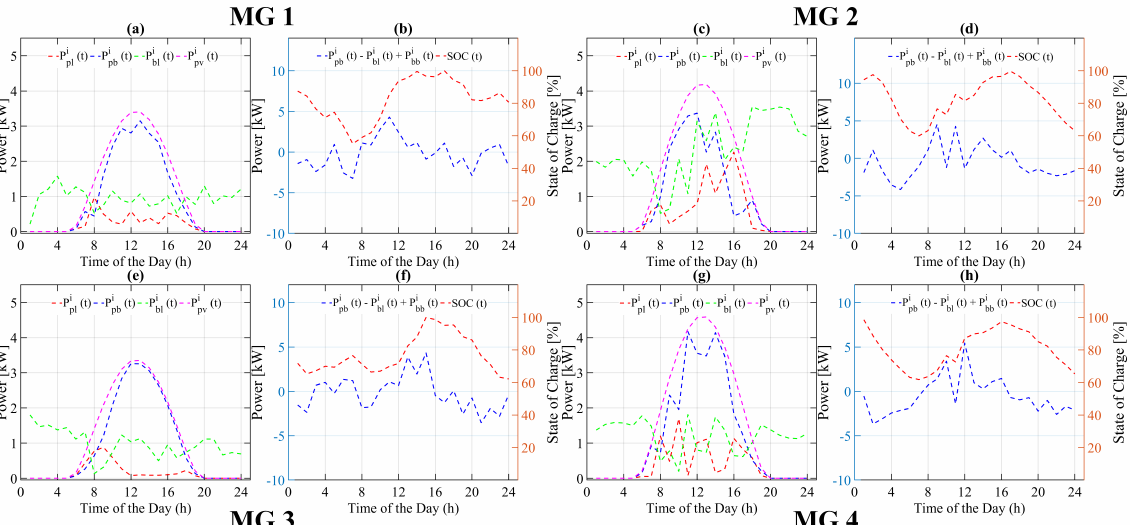
Figure 9. Power flow of various system variables of each microgrid using proposed optimization- based energy management strategy for case B. ( a , c , e , g ) Power flow of PV, battery and Load, ( b , d , f , h ) Battery charging/discharging and state of